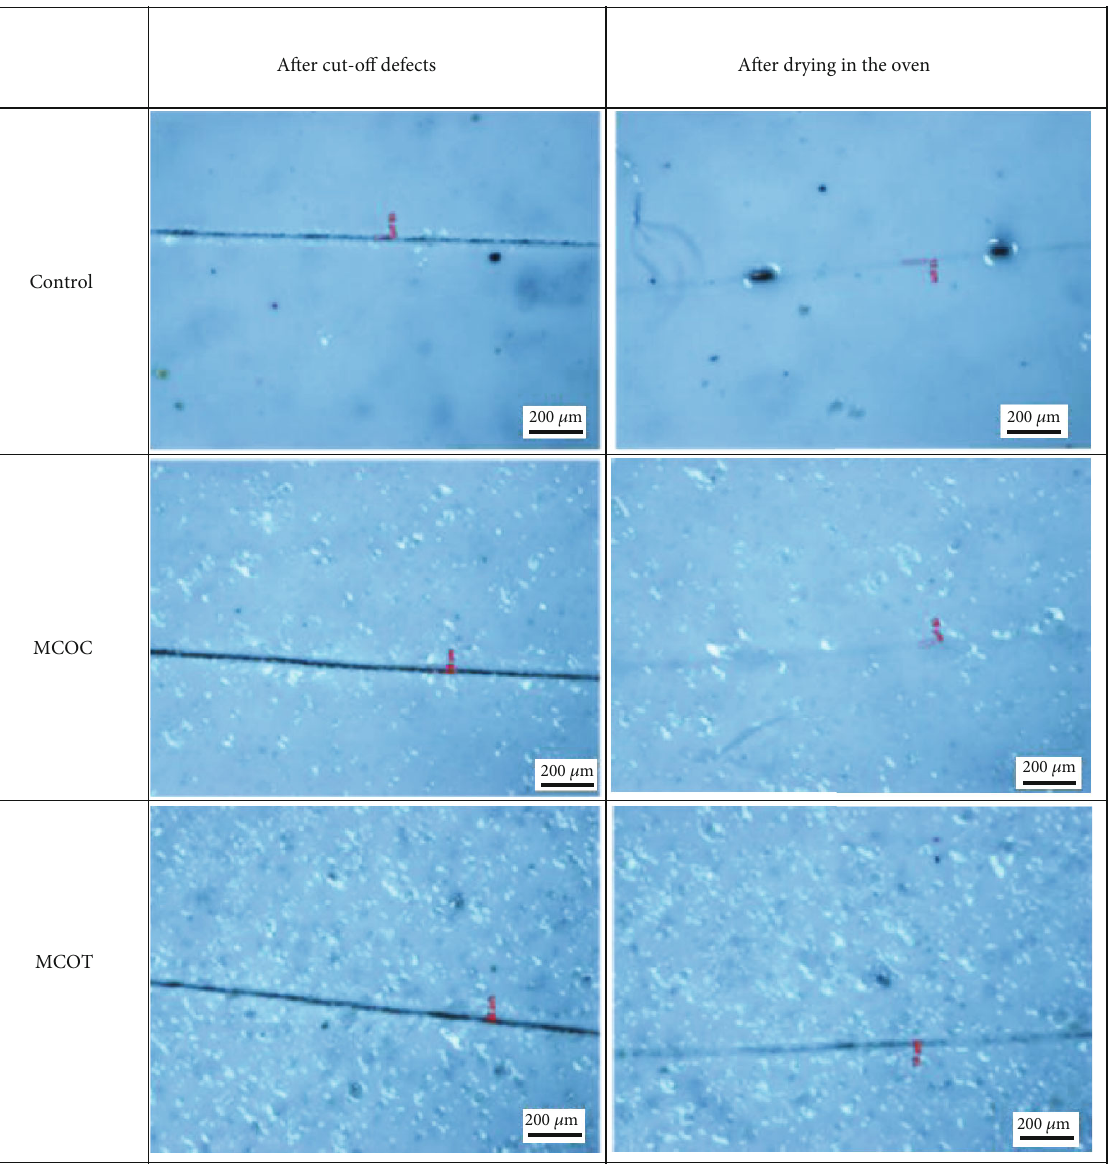
Figure 12: Optical microscopy images of the MCOC and MCOT control plates at the times after cutting and after the